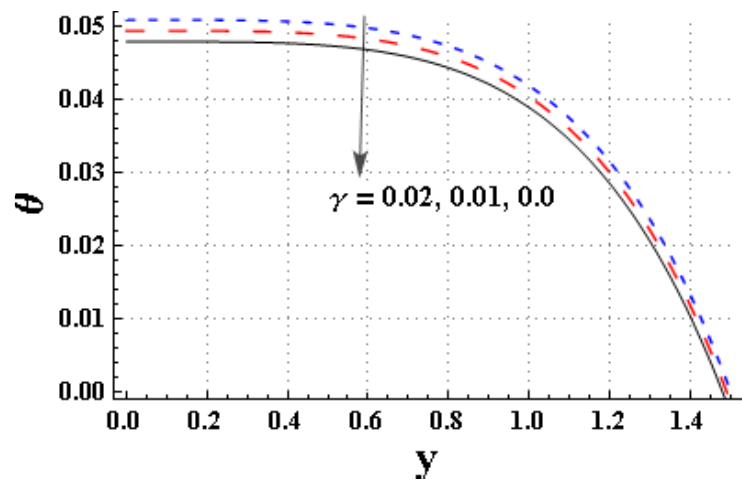
Figure 9. Effect of the Weissenberg number, W e , on temperature,  .